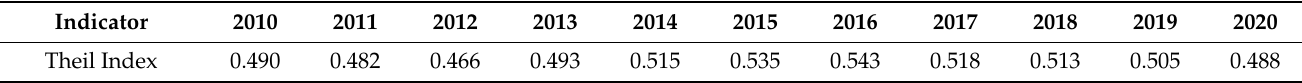
Table 2. Theil Index from 2010 to